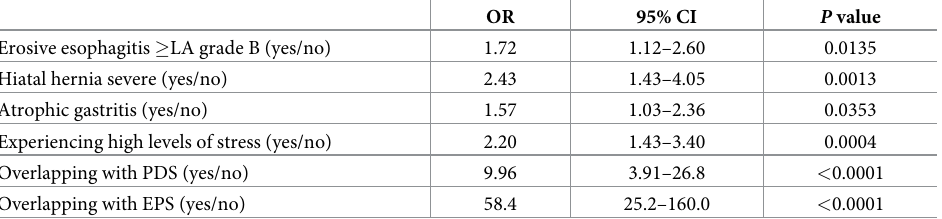
OR , odds ratio; CI , confidence interval; BMI , body mass index; PDS , postprandial distress syndrome; EPS , epigastric pain